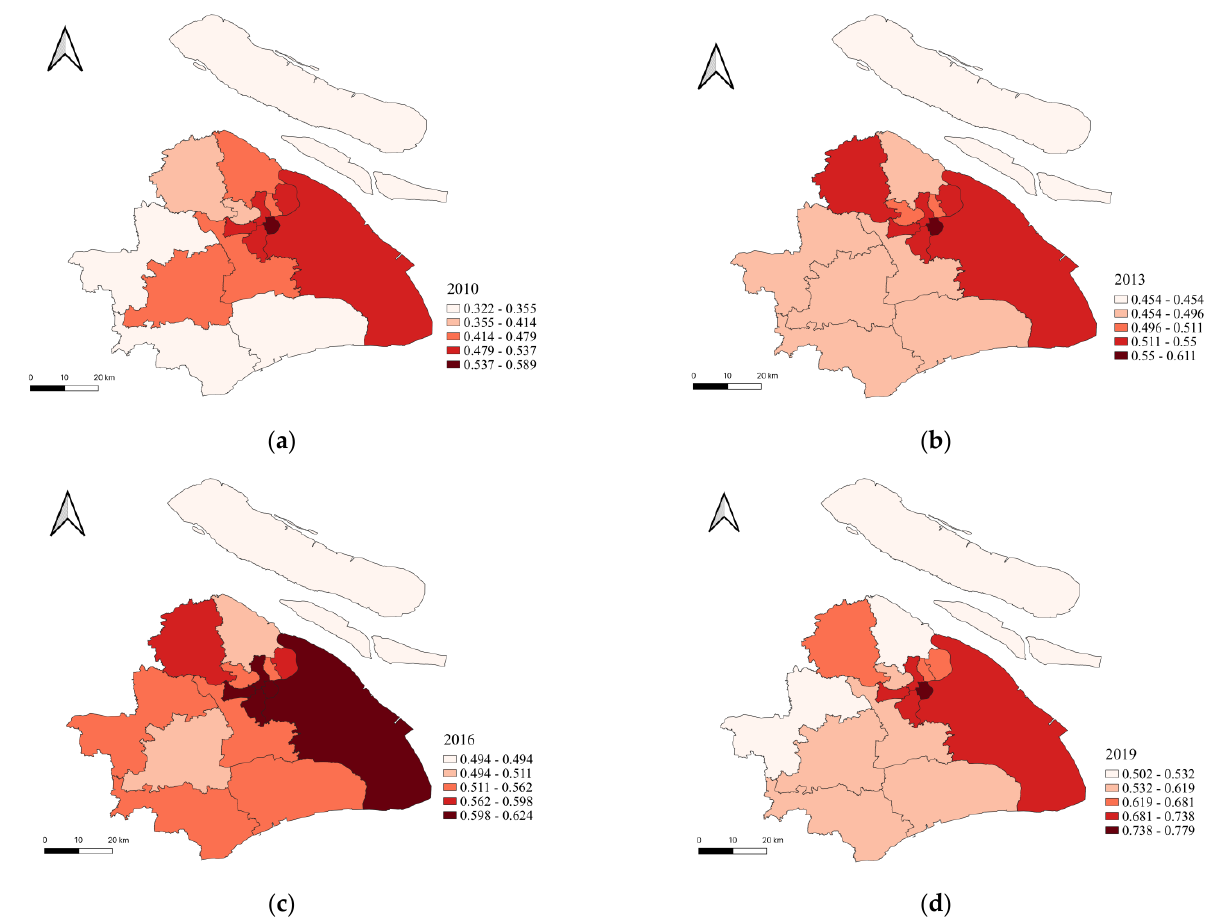
Figure 4. Spatial distribution of urban vitality of Shanghai. ( a ) Spatial distribution of urban vitality in 2010. ( b ) Spatial distribution of urban vitality in 2013. ( c ) Spatial distribution of urban vitality in 2016. ( d ) Spatial distribution of urban vitality in 2019.